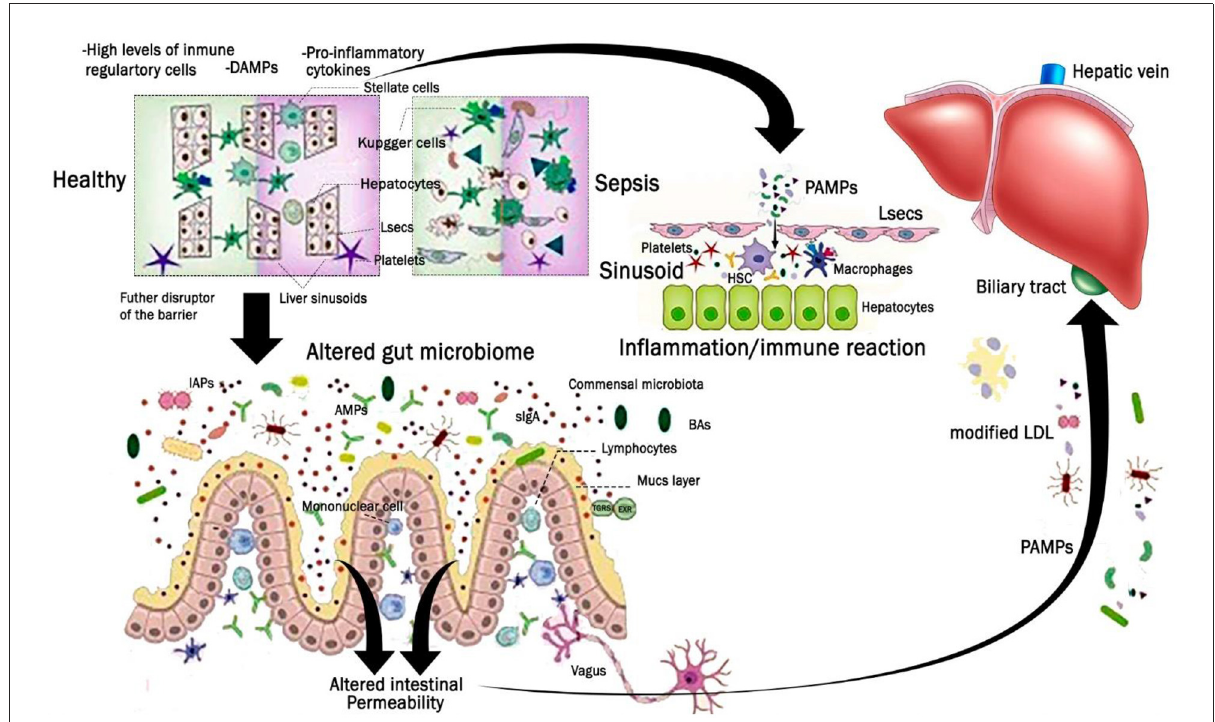
FIGURE1 Mechanism of sepsis and microbial behavior at the intestinal level. Based on Zhang et al. (2022). DAMPs, damage-associated molecular patterns; LSECs, hepatic sinusoidal endothelium; PAMPs, pathogen-associated molecular patterns. In sepsis several mechanisms disrupt the intestinal barrier, including apoptosis of intestinal epithelial cells; disrupting the mucosal layer and intercellular junctions, generating a translocation of intestinal pathogen-associated molecules into the liver via lymphatic vessels or the biliary tract in response to the spread of PAMPs and DAMPs and systematic